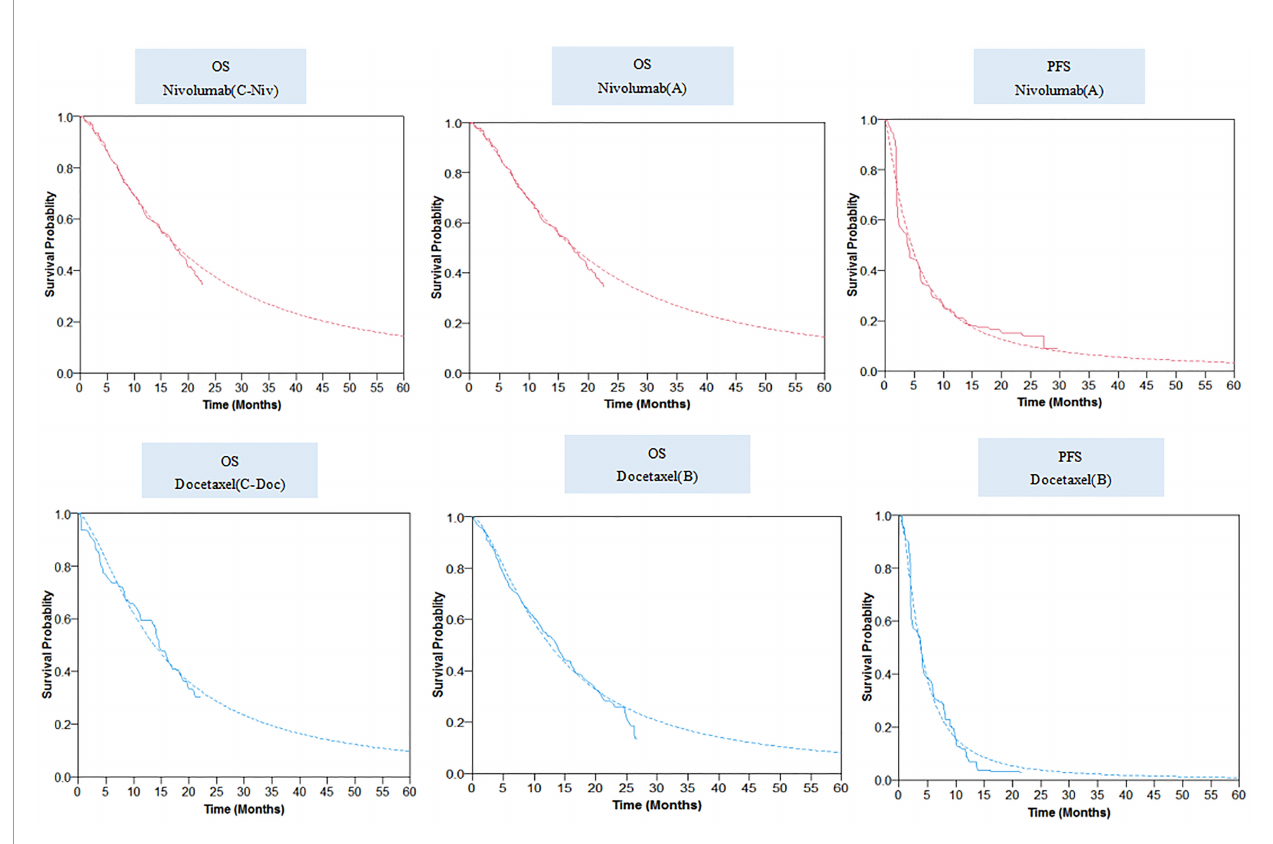
FIGURE 2 | Parametric survival distributions fi tted and extrapolated for OS and PFS data. The solid lines represented the observed data for each strategy; the dotted lines represented the fi tted data for each strategy. OS, overall survival; PFS, progression-free